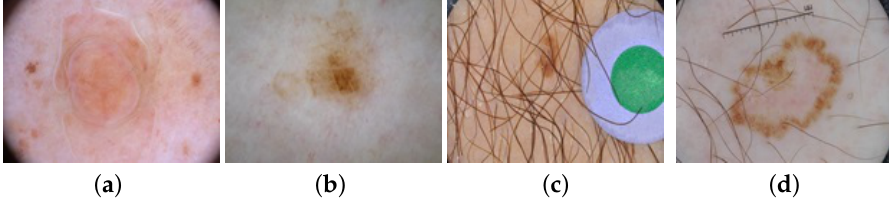
Figure 1. Some dermoscopic images with external interferences: ( a ) bubble occlusion; ( b ) low contrast in the surrounding; ( c ) hair covering; and ( d ) low contrast in the